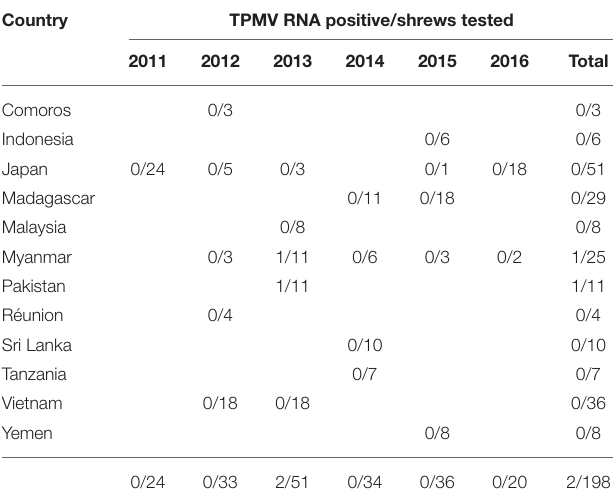
TABLE 1 | RT-PCR detection of TPMV RNA in Asian house shrews.